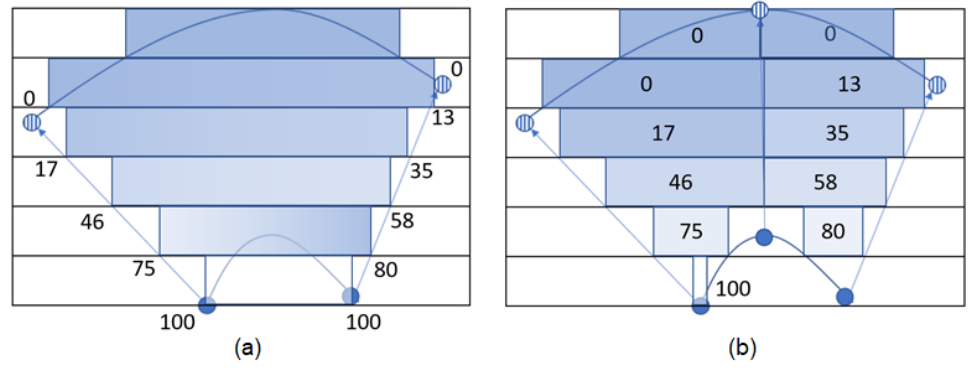
Figure 3. The notation of gradient distribution of two boundary curves.